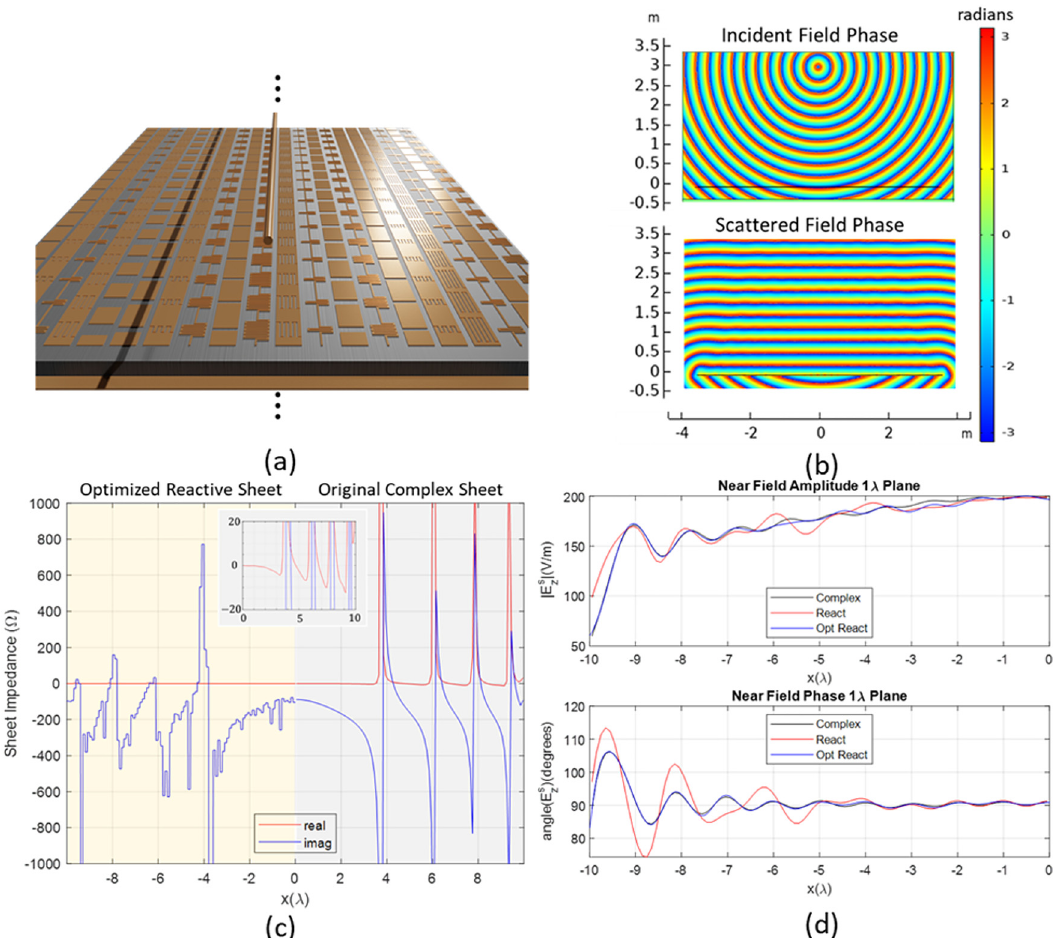
Figure 19: (Reprinted with permission from Ref. [32]). (a) The perfectly re fl ecting metasurface. The geometry is fi nite in the transverse directions and in fi nite and invariant in the axial direction (2D electromagnetics problem). (b) Phase plots of the incident and scattered fi elds. (c) Comparison of original complex-valued sheet impedance (right half) and optimized reactive sheet impedance (left half). (d) Comparisonof near fi eldsobservedataplane1 λ abovethemetasurfaceasscatteredbythecomplex-valuedsheet( ‘ Complex ’ ),thecomplex-valuedsheetwith resistances discarded ( ‘ React ’ ) and the optimized reactive sheet ( ‘ Opt React ’